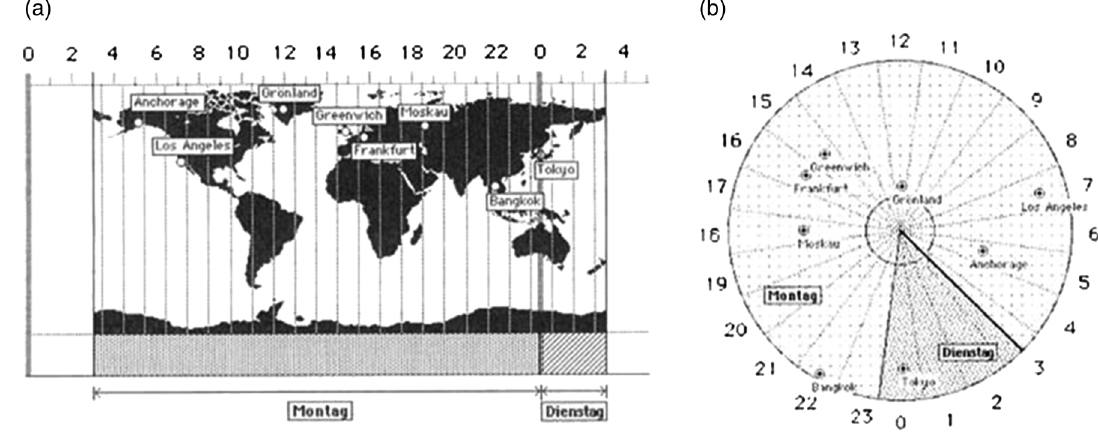
FIG. 2. Different types of graphical representation used in the experiments by Schnotz [16]. (a) Carpet diagram of time difference. (b) Circle diagram of time difference. Reproduced from Ref.